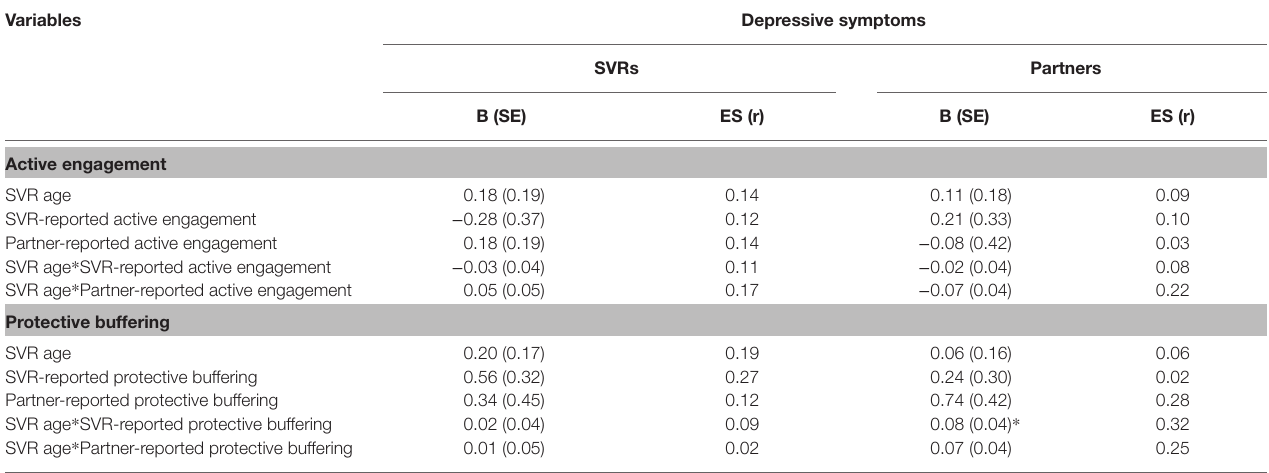
TABLE 4 | Moderating role of survivor age on associations between active engagement and protective buffering and depressive symptoms ( n = 49